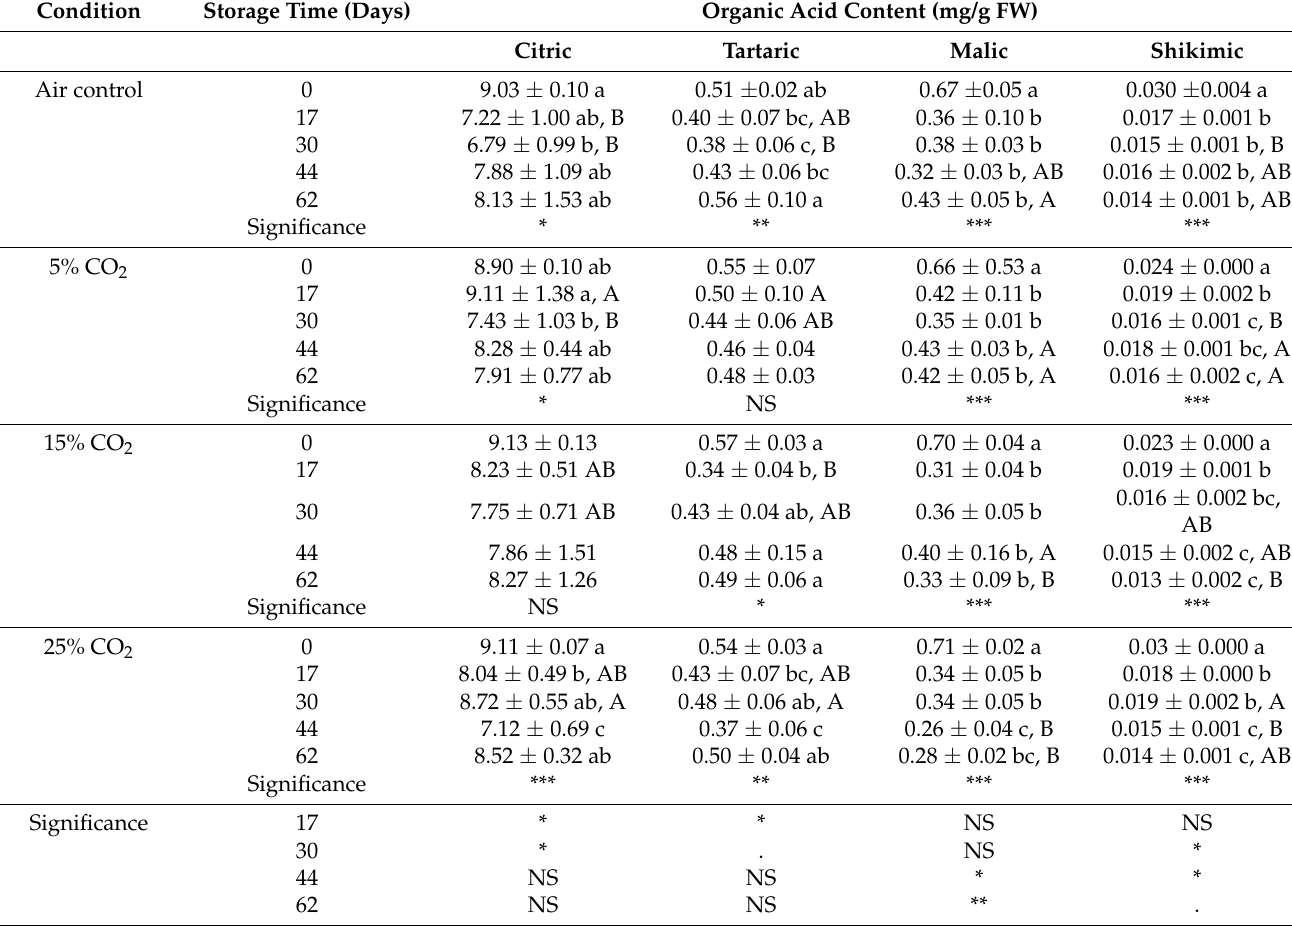
Table 2. Individual organic acids contents of blueberry ‘Liberty’ fruit for the air control and controlled atmospheres of: 5% CO 2 , 5% O 2 , 90% N 2 (5% CO 2 ); 15% CO 2 , 5% O 2 , 80% N 2 (15% CO 2 ); and 25% CO 2 , 5% O 2 , 70% N 2 (25% CO 2 ), according to length of